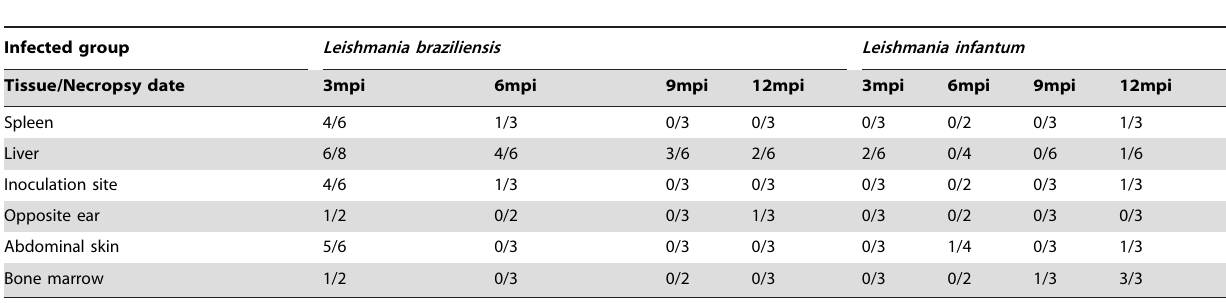
Table 1. Detection of Leishmania sp. DNA by polimerase chain reaction (PCR) in different tissues sampled from Thrichomys laurentius experimentally infected by Leishmania braziliensis or Leishmania infantum between months 3 and 12 post infection.